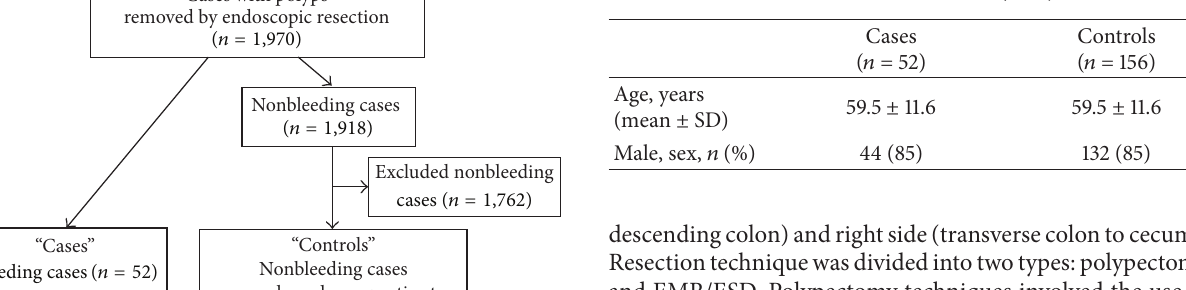
Table 1: Characteristics of study